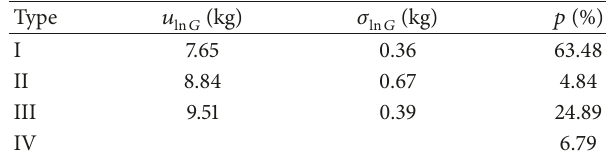
Table 1: Statistical parameters of vehicle